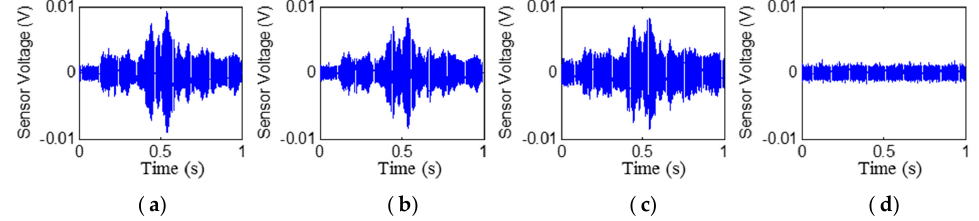
Figure 7. Signal received by PZT 4 (PZT3–PZT4 pair): Stage 0 to Stage 3 from left to the right. ( a ) Stage 0; ( b ) Stage 1; ( c ) Stage 2; ( d ) Stage 3.